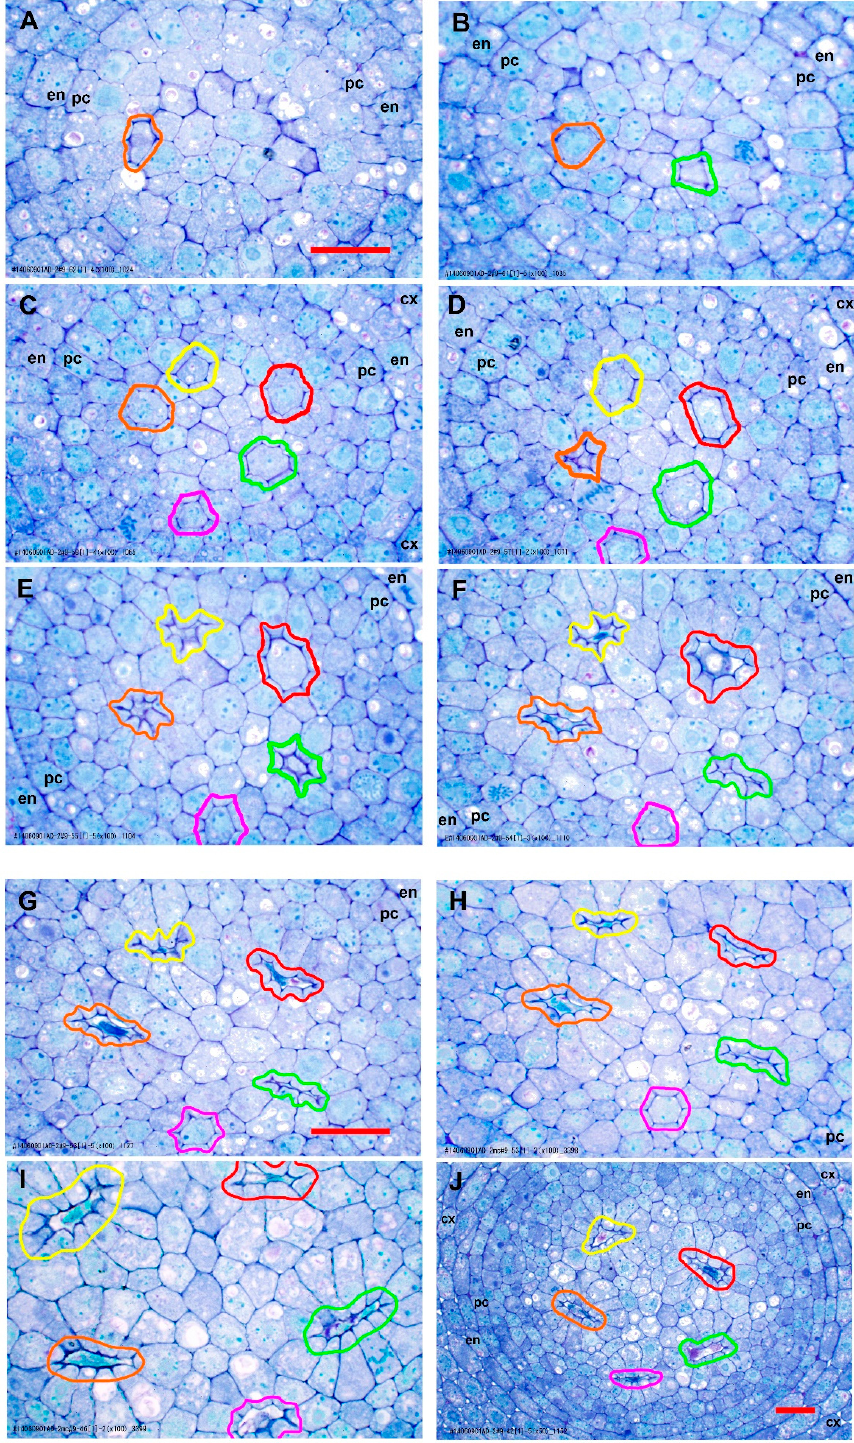
Figure 5. Abnormal LMX and first EMX development revealed by representative transverse sections from among ca. 335 serial sections taken from one teosinte primary root. ( A ) Appearance of first LMX element (orange) 34 µm from RCJ. ( B ) Appearance of the second LMX element (green) 46 µm from RCJ. ( C ) The third (red) and fourth (yellow) LMX elements were differentiated by 78 µm from RCJ, and all elements appeared normal. ( D ) The first-formed LMX vessel (orange) began collapsing by 92 µ m from the RCJ, about the same time the first EMX element (magenta) could be discerned. A cell adjacent to the collapsing element was in mitosis. ( E ) The second (green) and fourth (yellow) LMX elements